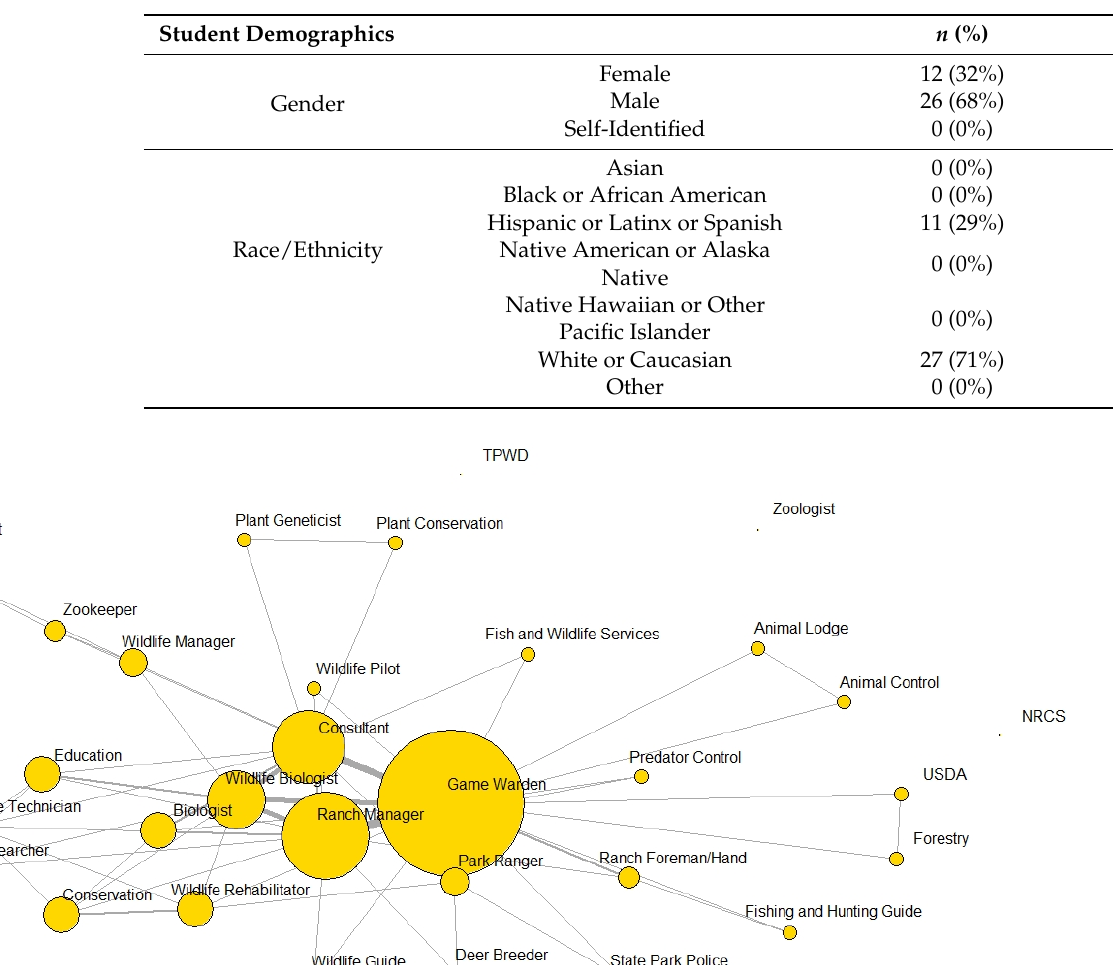
Table 1. Reported gender and race/ethnicity of 38 total student participants in the citizen science experience at Texas A&M University-Kingsville, Kingsville, TX, USA in Fall 2016.